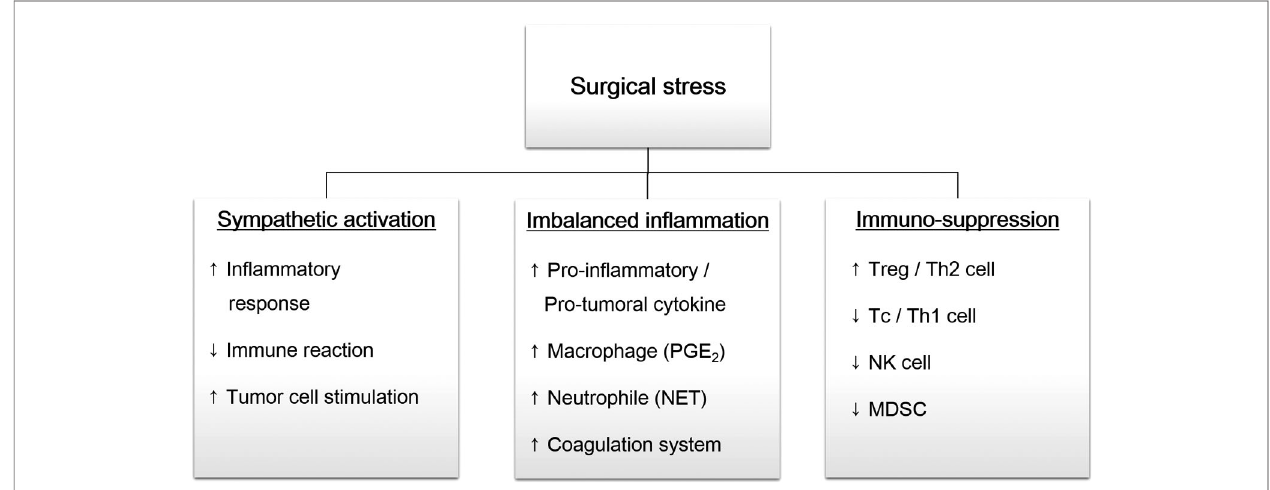
FIGURE 1 | Overview of surgical stress response. Surgical trauma induce sympathetic activation, followed by imbalanced in fl ammation and immunosuppression. These changes promote remnant tumor cells survival and distant metastasis. PGE2, prostaglandin E2; NET, neutrophil extracellular traps; Treg, regulatory T cell, Th, helper T cell; Tc, cytotoxic T cell; NK cell, natural killer cell; MDSC, myeloid-derived suppressor